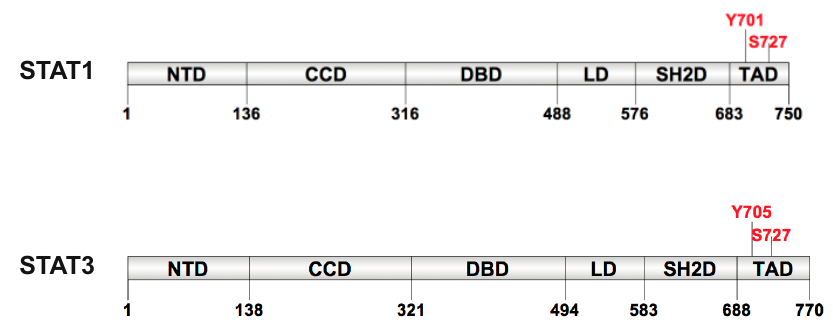
Figure 1. Schematic representation of STAT1 and STAT3 domains. STATs structure is composed by N-domain (NTD), coiled-coil domain (CCD), DNA binding domain (DBD), linker domain (LD), Src homology 2 domain (SH2D) and transcriptional activation domain (TAD). Between SH2D and TAD there is a tail segment that contains the Tyrosine and Serine phosphorylation sites.